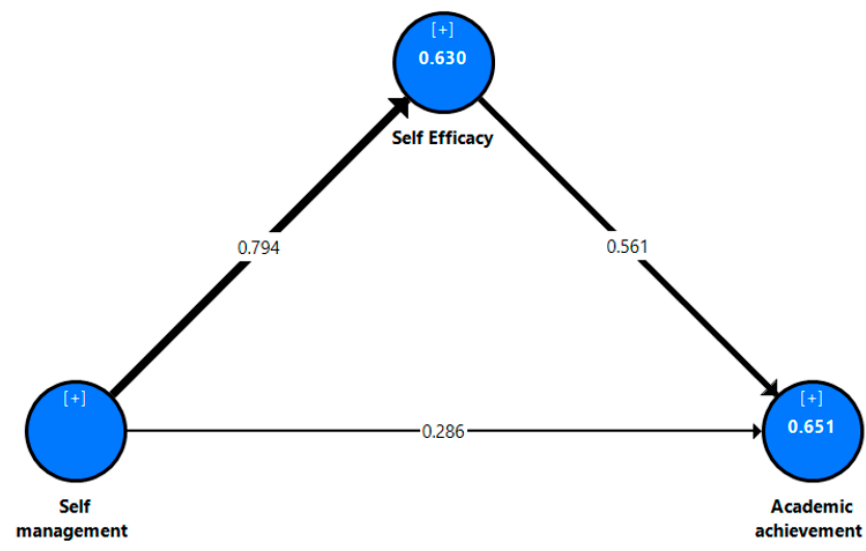
Figure 4. Results of the structural model with data from the Saudi students.